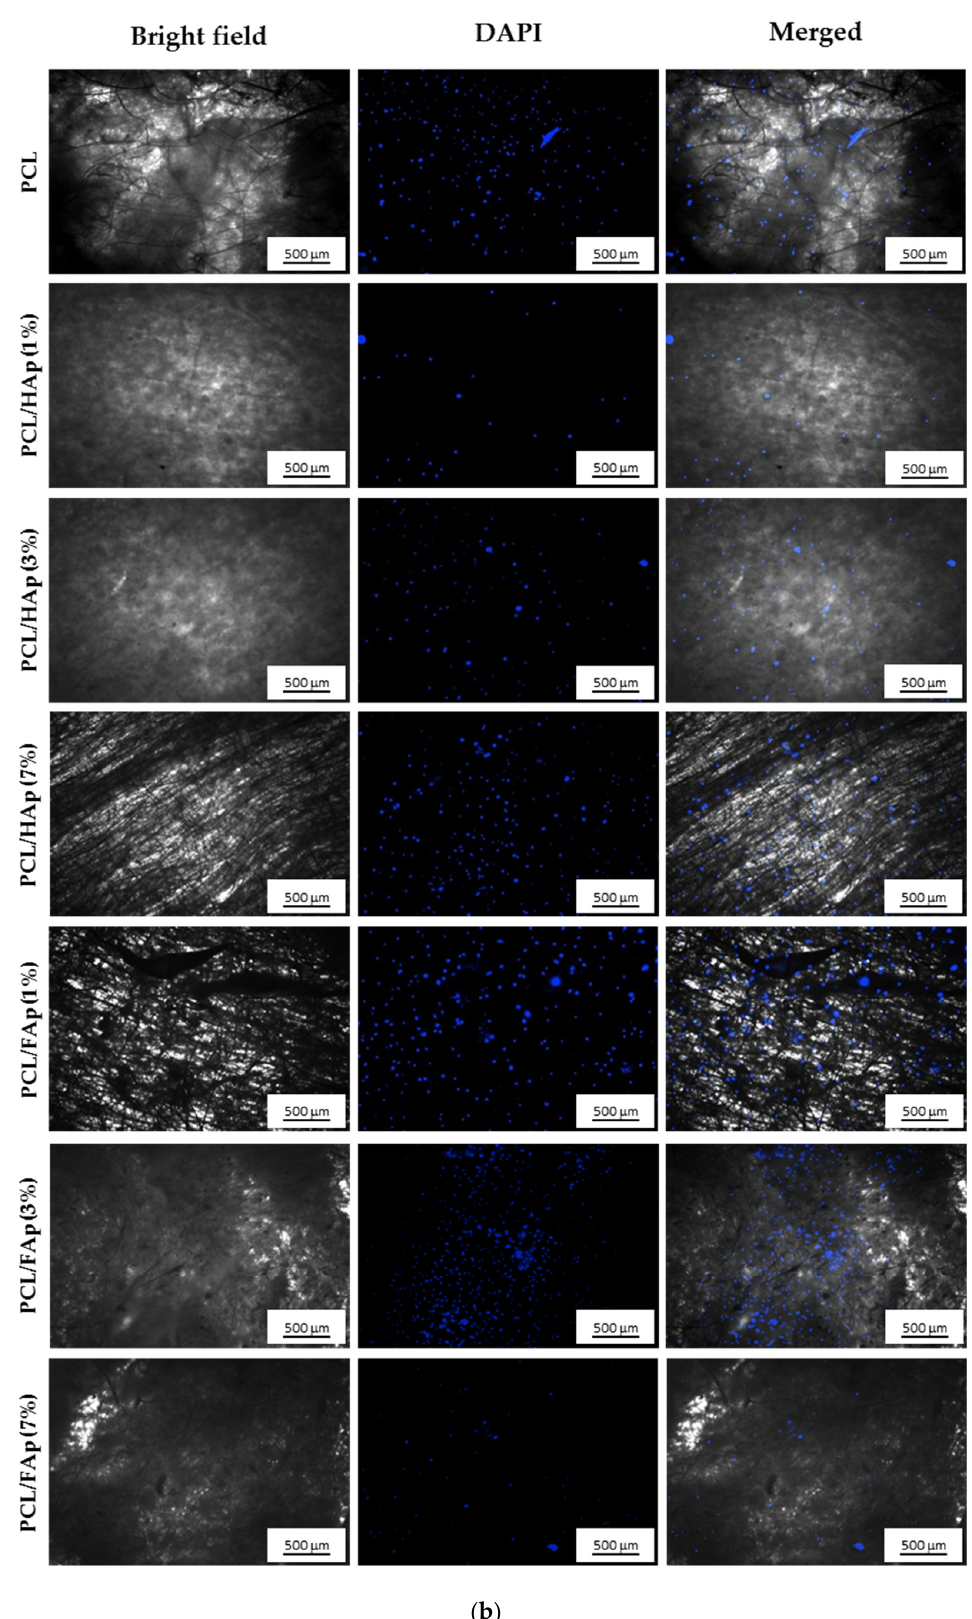
Figure 4. ( a ) Fluorescence microscope images for DAPI staining (blue nucleus) of mouse C2C12 cells seeded onto the pure PCL and PCL scaffolds containing 1%, 3% and 7% of HAp or FAp after 7